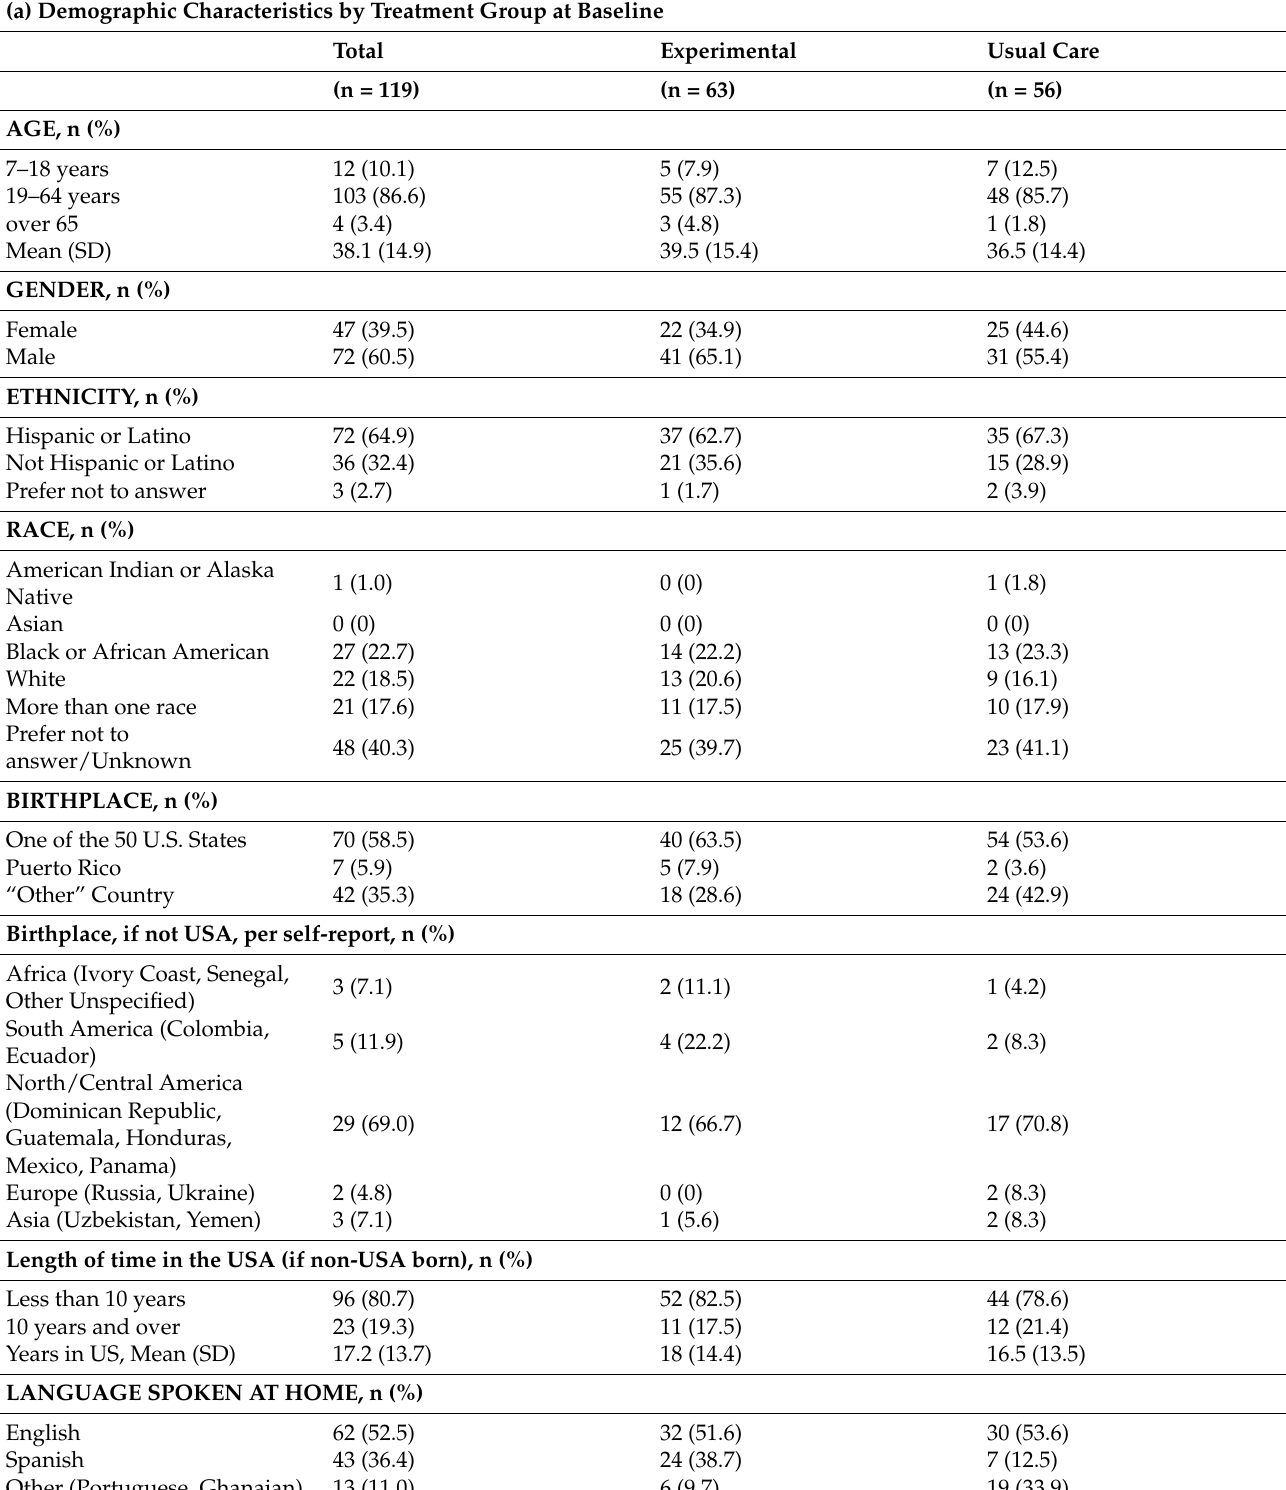
Table 1. Comparison of Study Participants at Baseline for (a) demographics, (b) clinical comorbidity and health care utilization, and (c) occupational and social